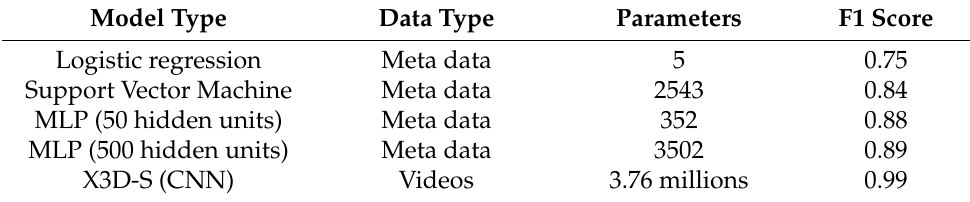
Table 2. Classification performance on the test set using the meta-data.